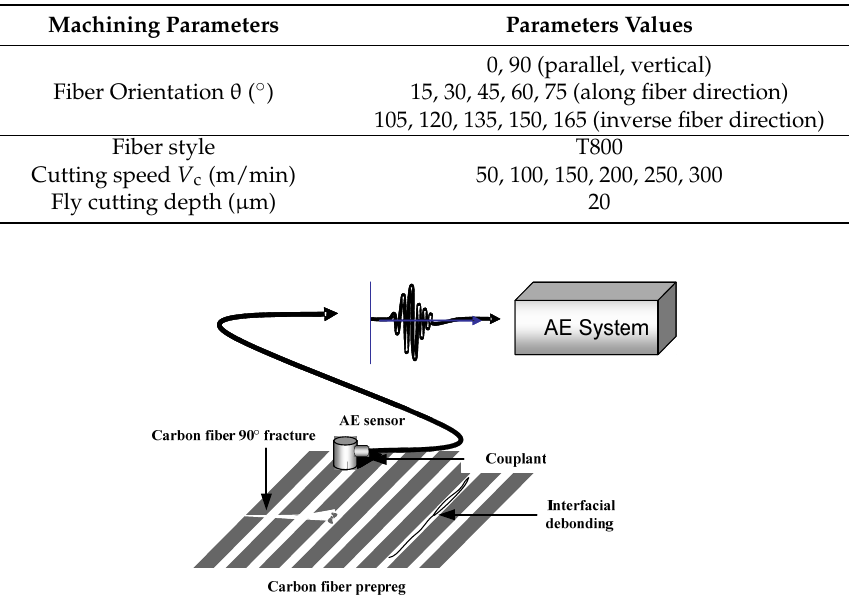
Table 2. Machining parameters in single point cutting prepreg materials.